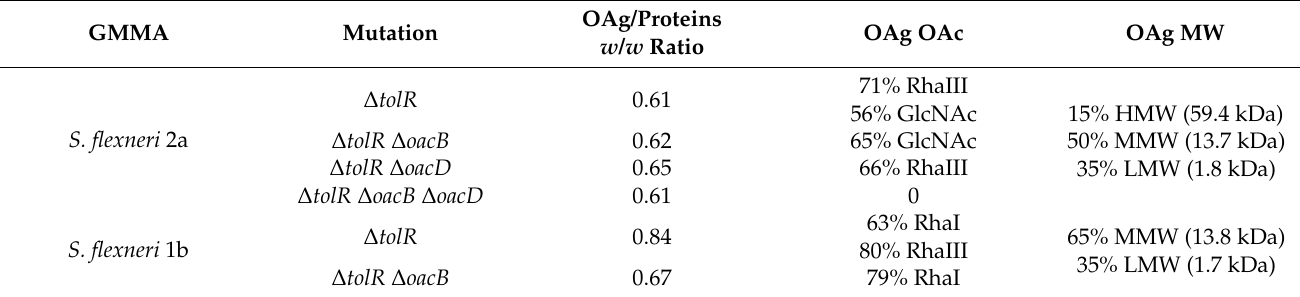
Table 1. Analytical characterization of GMMA displaying OAg with different O-acetylation.